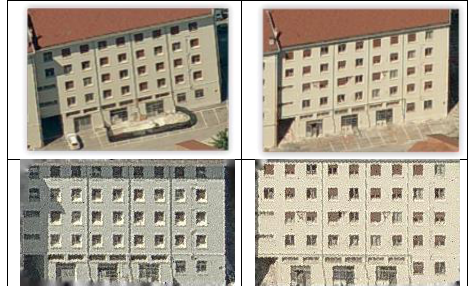
Figure 12. Example of two pre- and post-event subsets of oblique images containing the façade (above) and respective rectified images (below).